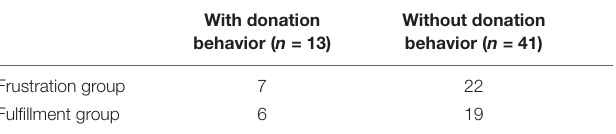
TABLE 4 | Number of participants with tendency toward altruistic behavior by group.